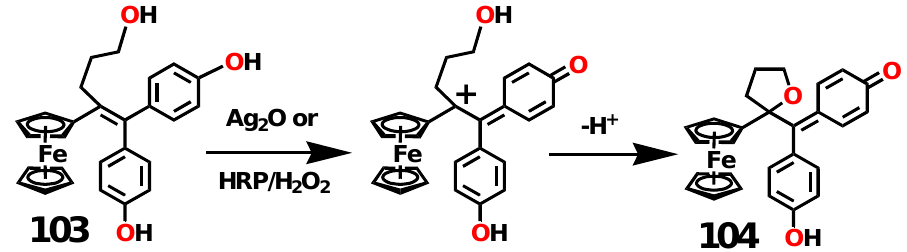
Scheme 33. Chemical or enzymatic oxidation of the hydroxypropyl-ferrociphenol, 103 , yields the tetrahydrofuranyl-quinone methide, 104